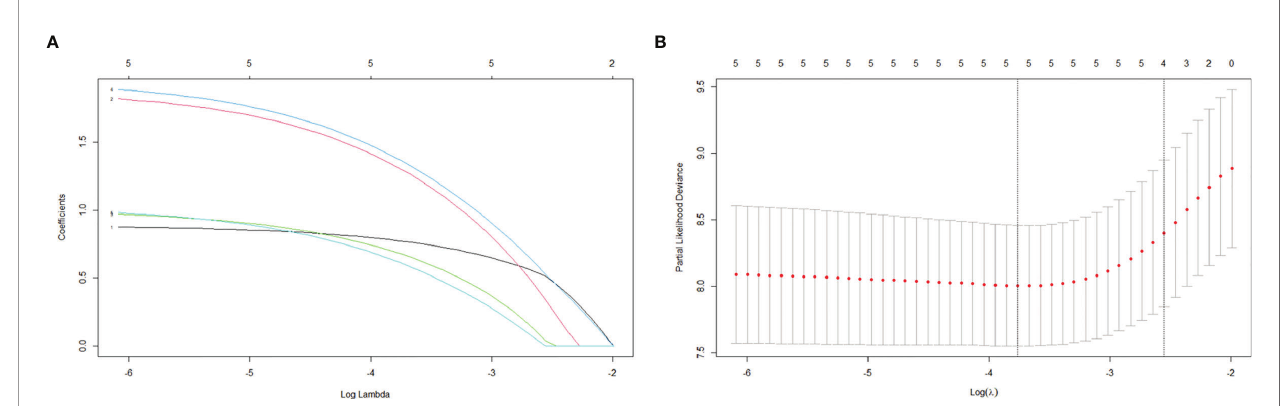
FIGURE 1 | LASSO regression analysis for variable selection. (A) LASSO regression coef fi cients. (B) LASSO cross-validation.